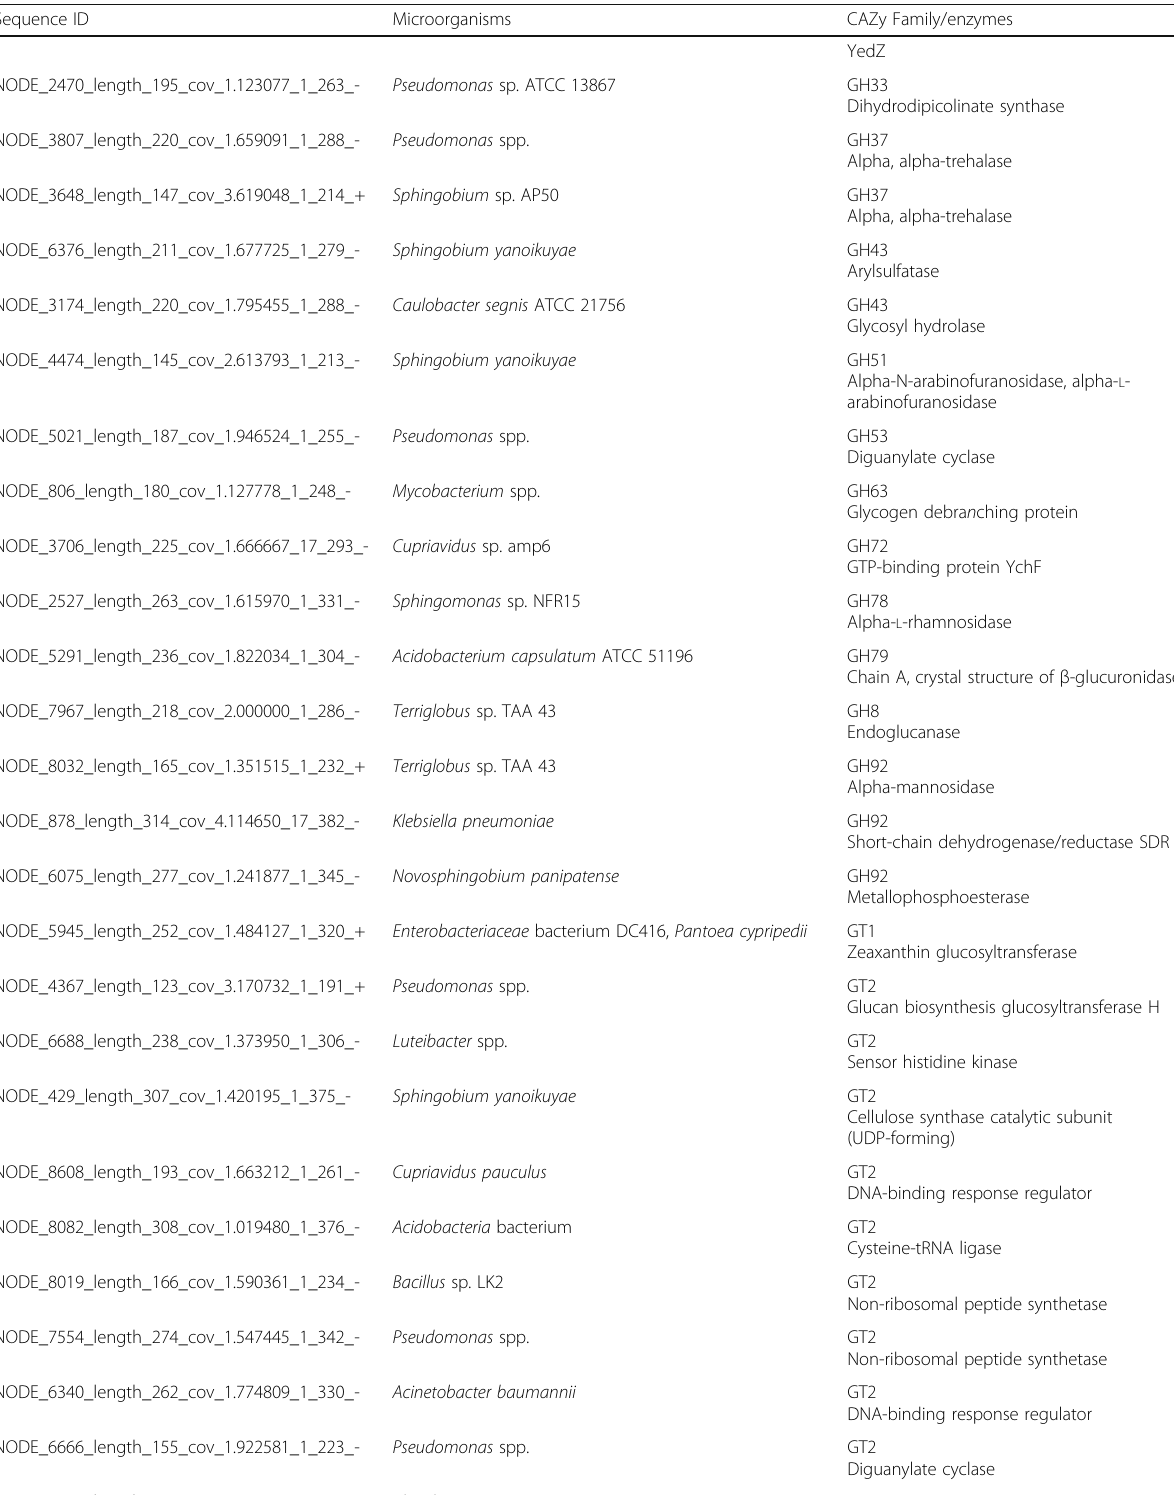
Table 2 List of AB1 microcosm sequences annotated for carbohydrate-active enzymes (CAZy) and their taxonomic affiliations